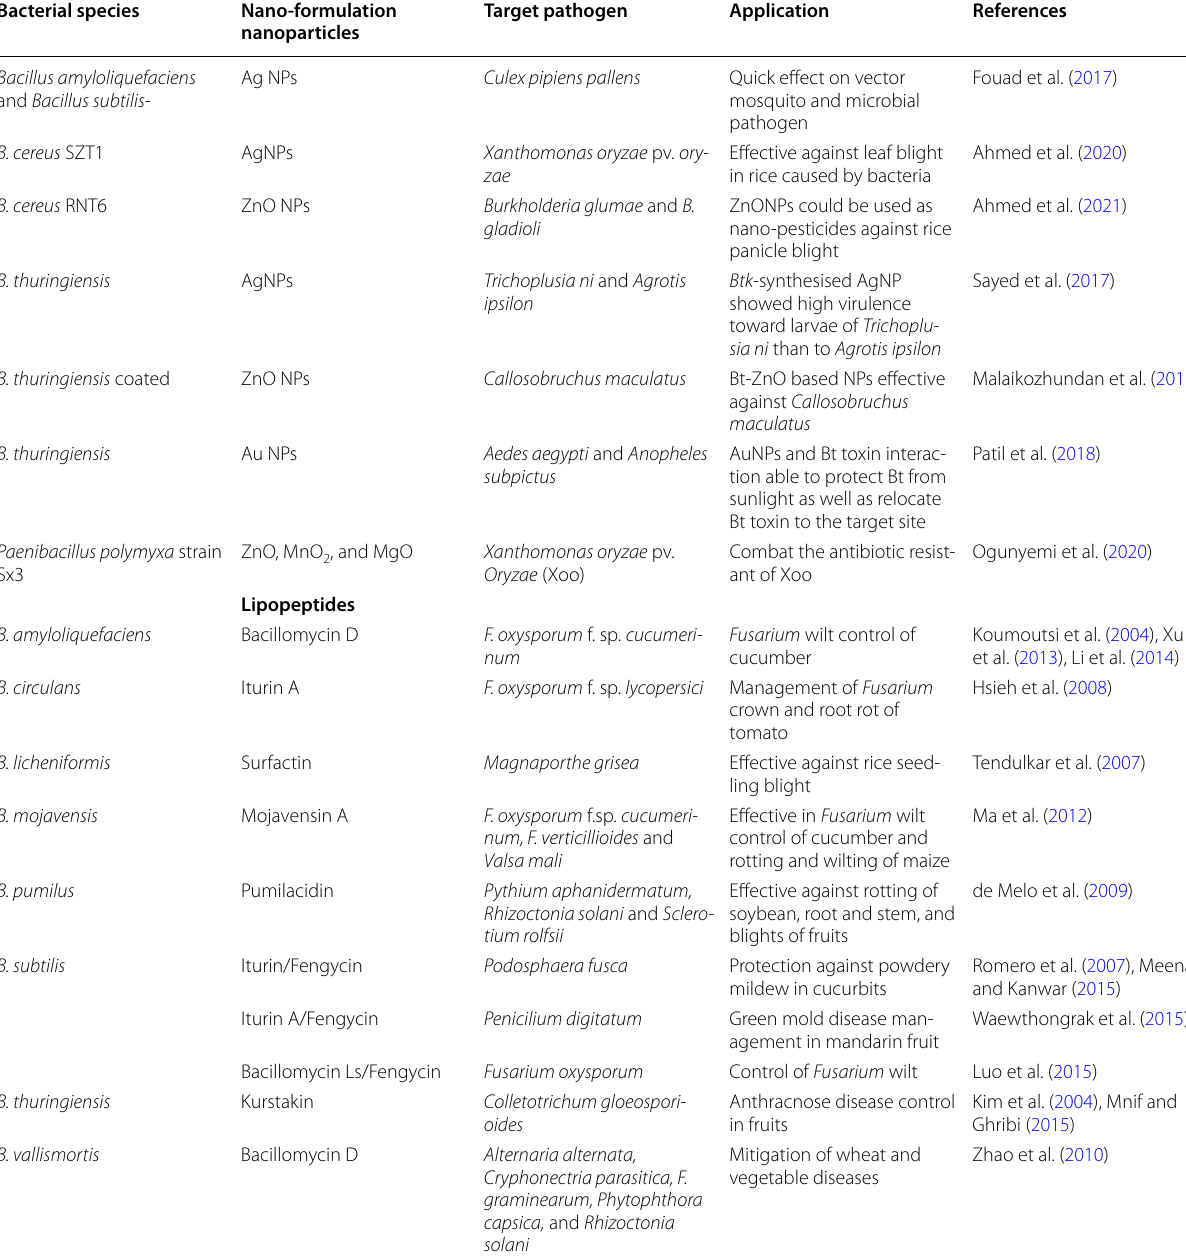
Table 1 Bacteria-based nano-formulations (nanoparticles/lipopeptides) and their applications against phytopathogens and